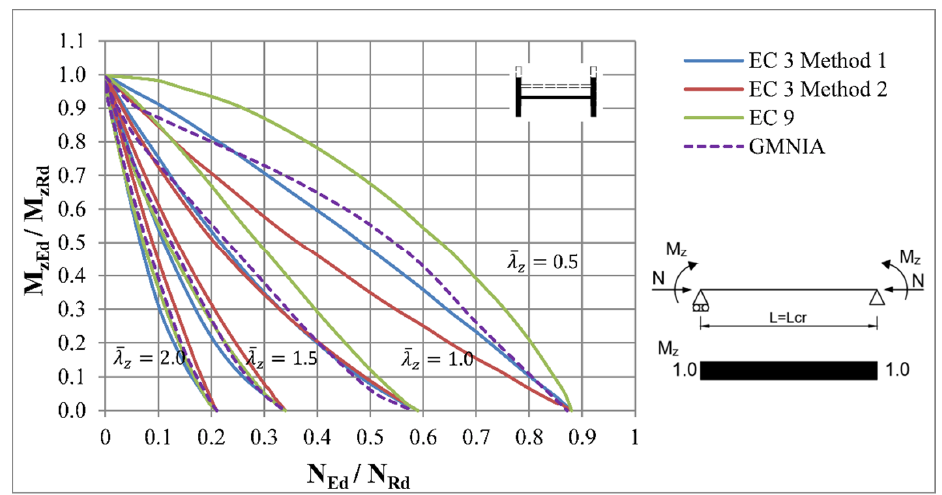
Figure 26. Interaction curves for weak axis flexural buckling of beam-columns with IPE 100 cross- section.